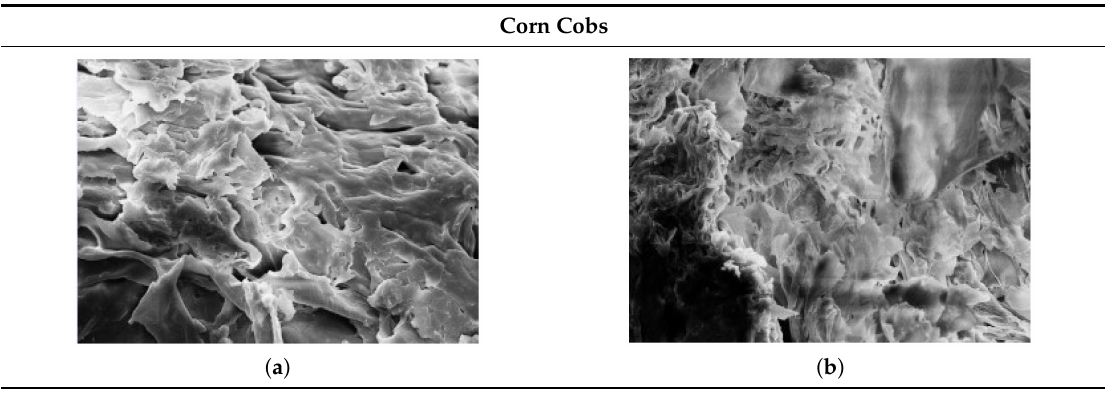
Table A2. SEM images of investigated lignocellulosic materials: ( a ) Raw material; ( b ) Material after alkaline pre-treatment; ( c ) Material after enzymatic hydrolysis; ( d ) Alkaline pre-treated and enzymatically hydrolyzed